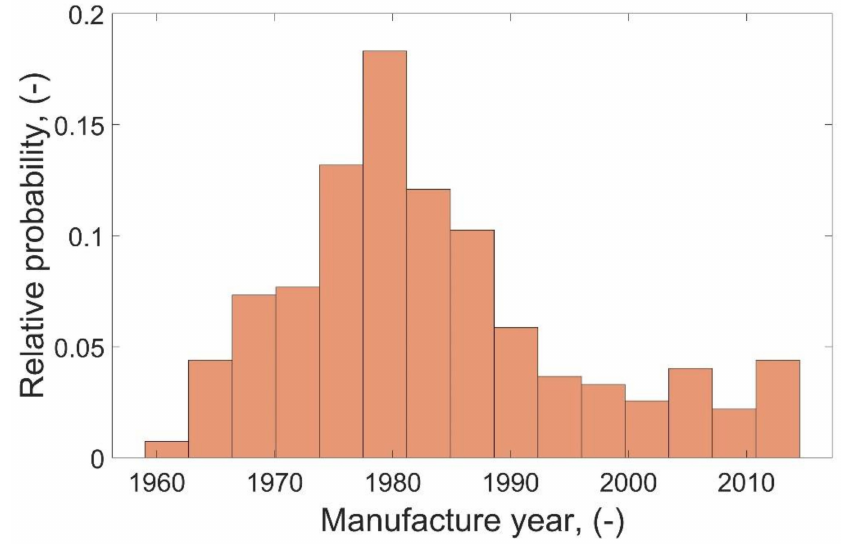
Figure 1. Age structure of the analyzed transformers population (status as of the end of